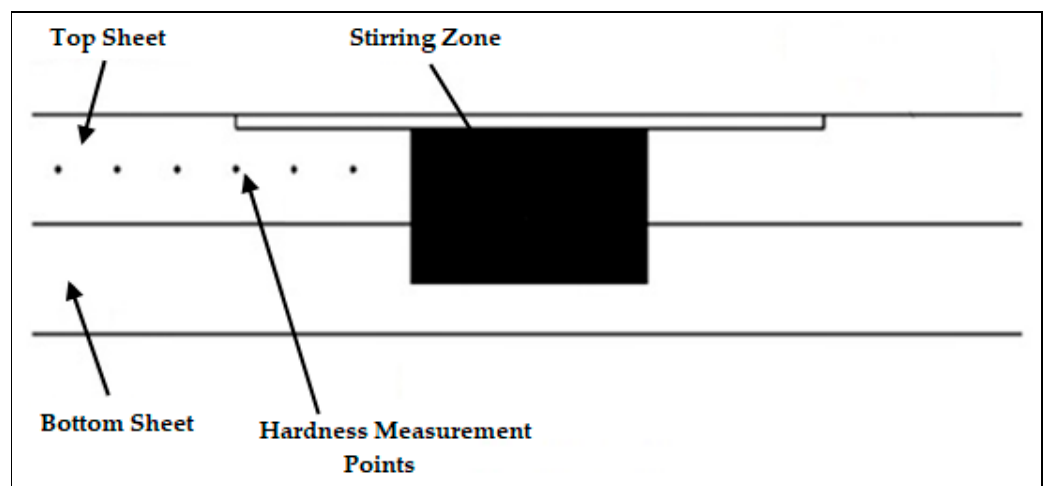
Figure 6. The microhardness measurement position of the sample.